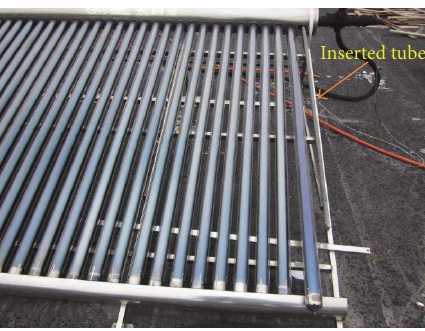
Figure 5: The picture of solar water heater with a novel collector manifold header.